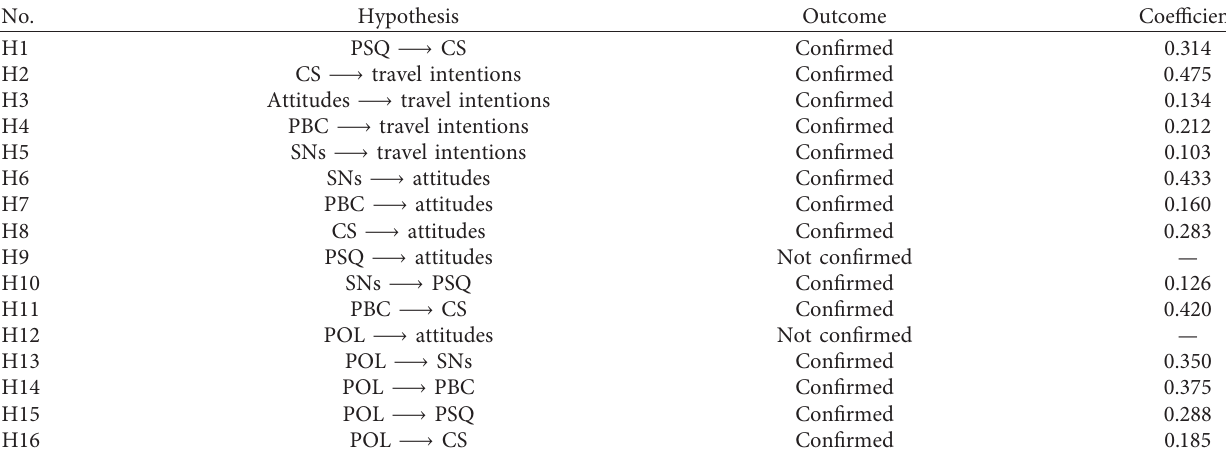
Figure 2: The results of the PLS-SEM model. Table 5: Summary of the outcomes of the hypothesis